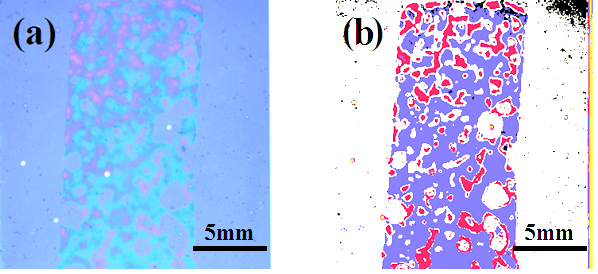
Figure 10. The image recognition steps of ( a ) initial and ( b ) contrast enhanced